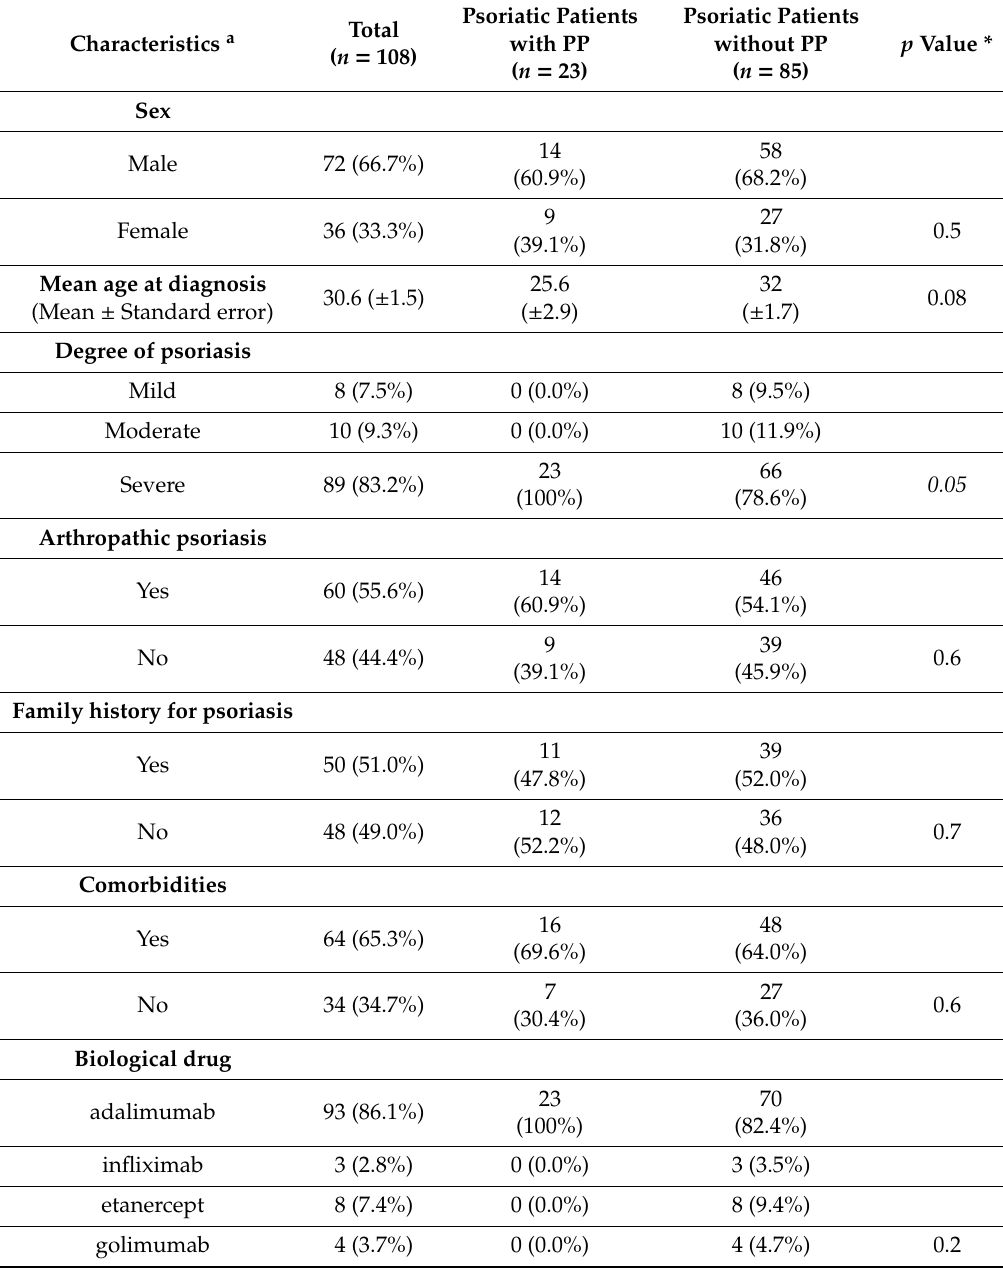
Table 2. Clinical–pathologic characteristics of psoriatic patients with and without